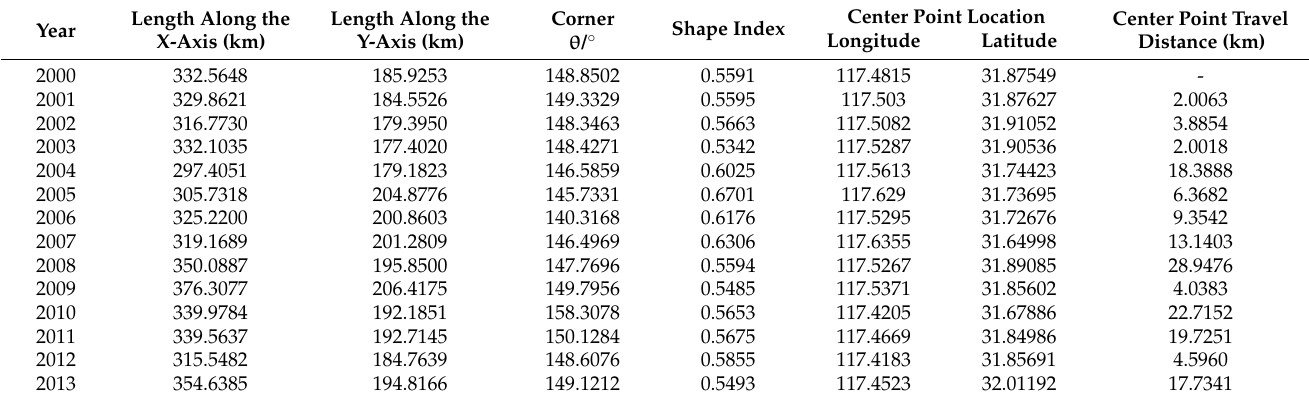
Table 5. Standard deviation ellipse parameters of GIOV in Anhui Province from 2000 to 2013.